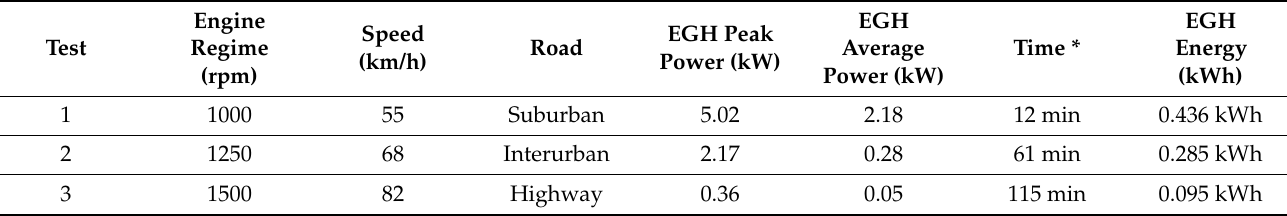
Table 3. EGH power requirements to achieve 95% of SCR